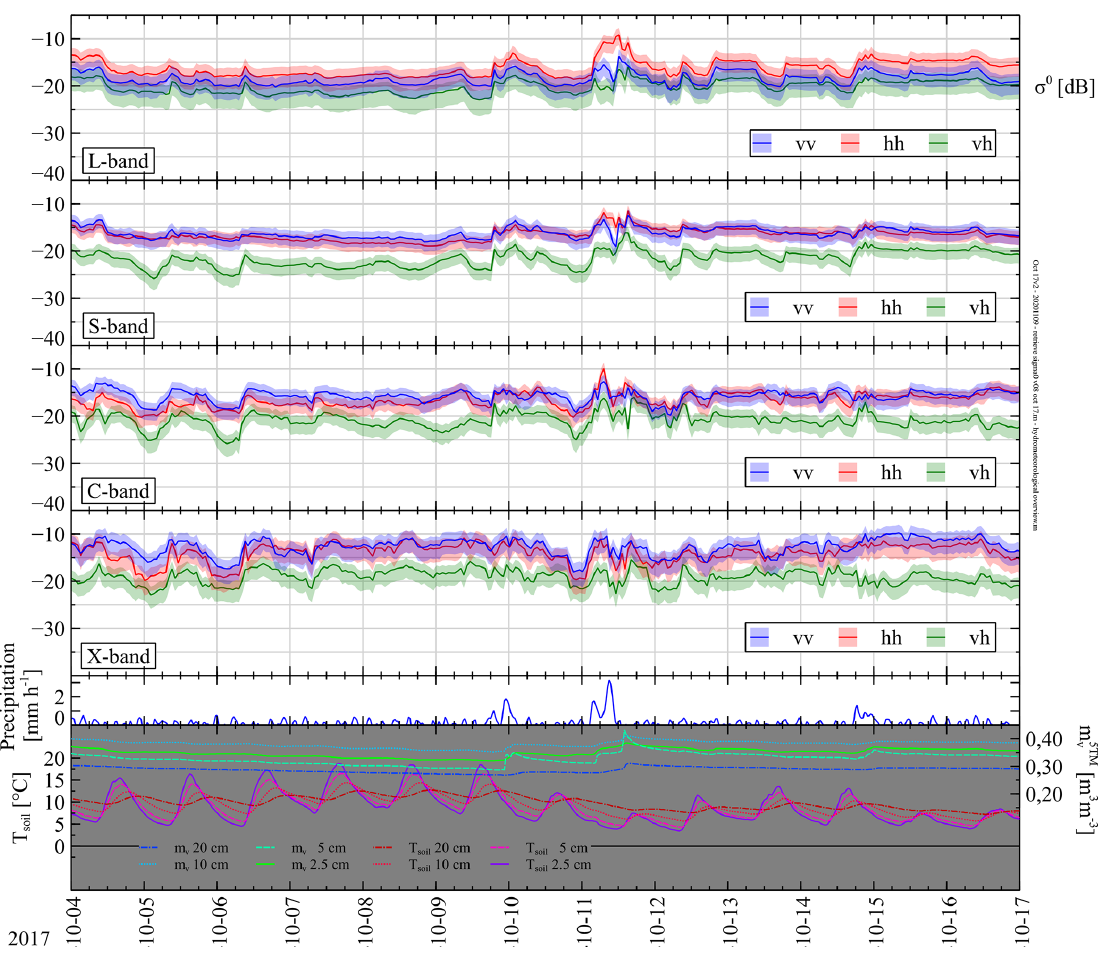
Figure D1. Time-series measurements of σ 0 pq (m 2 m − 2 ) for L-, S-, C-, and X-band, precipitation, M v , and T soil during 13d in October 2017. Shaded regions indicate 66% confidence intervals for σ 0 pq . The antenna boresight angle was fixed at α 0 = 55 ◦ . The incidence angle ranges were band and polarization dependent. The widest ranges were 0 ◦ ≤ θ ≤ 60 ◦ for L-band, 20 ◦ ≤ θ ≤ 60 ◦ for S-band, 36 ◦ ≤ θ ≤ 60 ◦ for C- band, and 47 ◦ ≤ θ ≤ 59 ◦ for X-band. Bottom graphs show measured precipitation (mmh − 1 ), volumetric soil moisture m 5TM v (m 3 m − 3 ), and soil temperature T soil at indicated depths. Spatial average volumetric soil moisture content M v is estimated as M v = m 5TM v ± 0 . 04m 3 m − 3